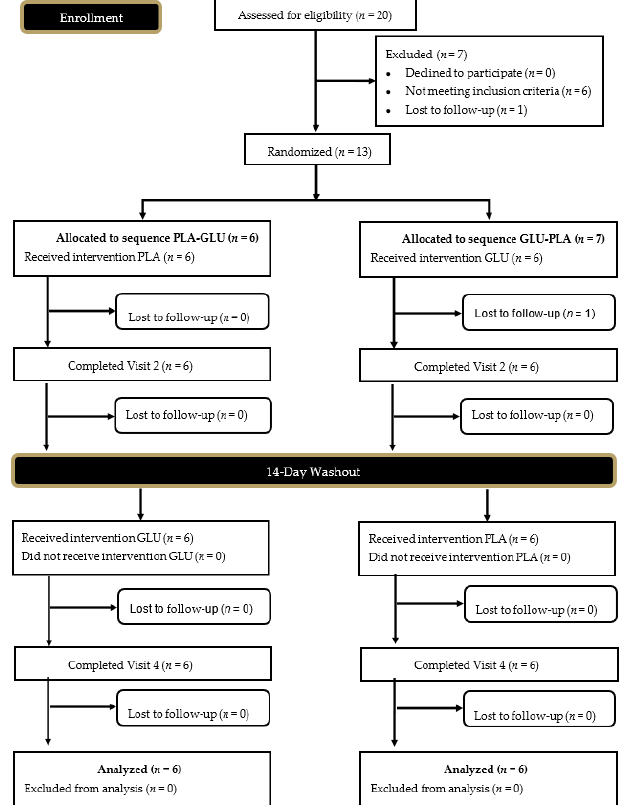
Figure 2. Consolidated Standards of Reporting Trials (CONSORT) Diagram Procedures. Glucosamine (GLU) , Placebo (PLA).